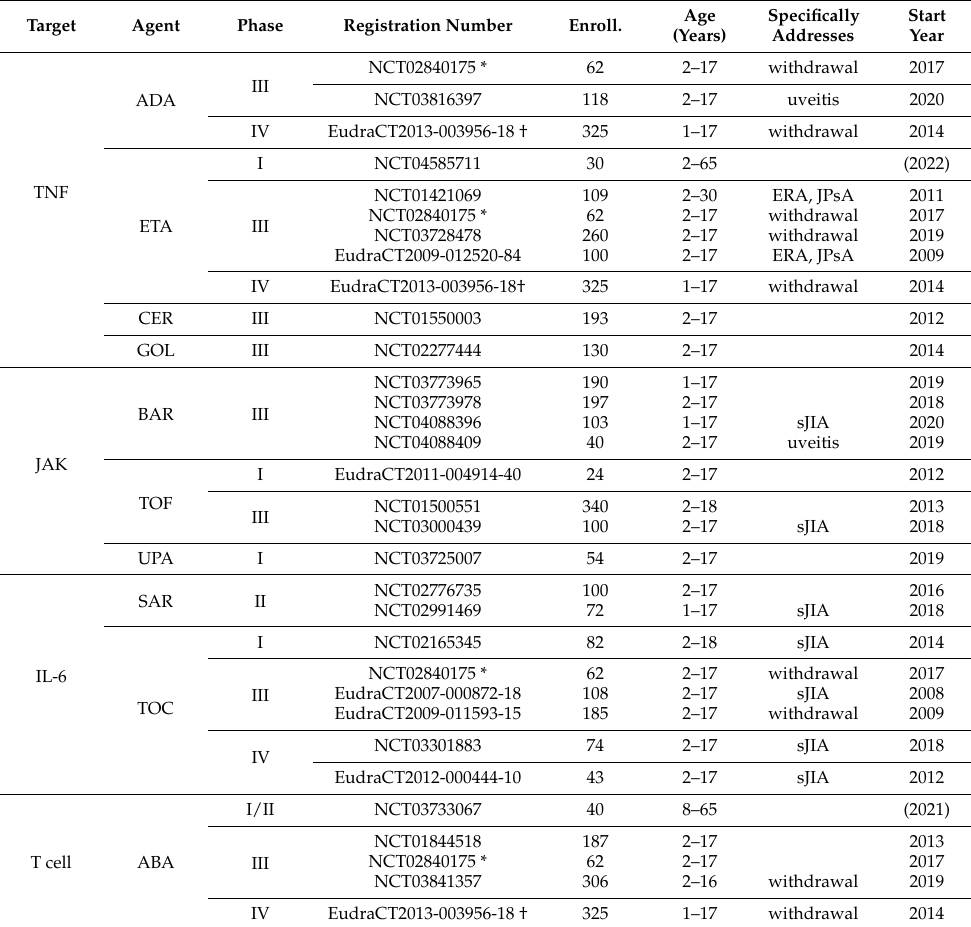
Table 2. Registered interventional studies involving bDMARD and tsDMARD agents, clinical phases, and planned enrollments. *, † refer to studies involving multiple bDMARDs. Start year in brackets refers to studies with start date in future of data acquisition. ERA—enthesitis-related arthritis, IL— interleukine, JAK—janus kinase, JPsA—juvenile psoriatic arthritis, sJIA—systemic JIA, TNF—tumor necrosis